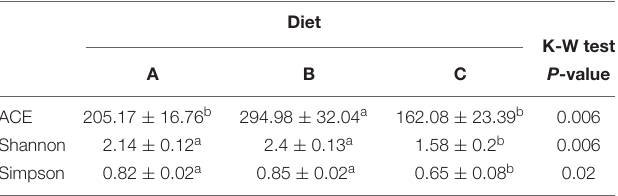
TABLE 5 | Species richness estimate (ACE) and diversity indexes (Shannon and Simpson) of the adherent microbial communities in the anterior intestine of fish fed diet A (10), diet B (10), and diet C (7).